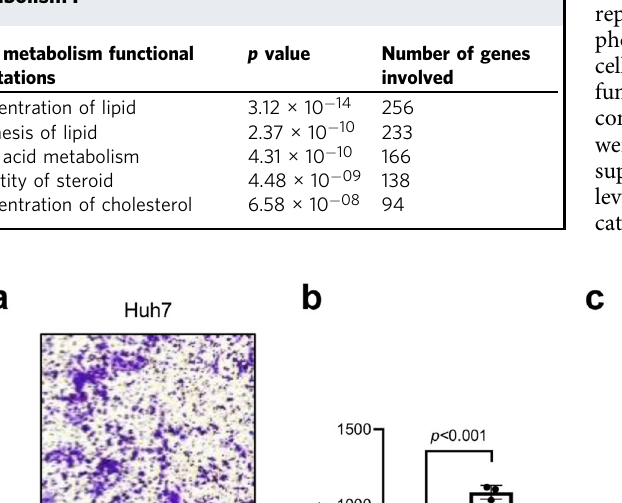
Table 3 Top- fi ve ranked IPA-annotations associated to ‘ lipid metabolism ’ .